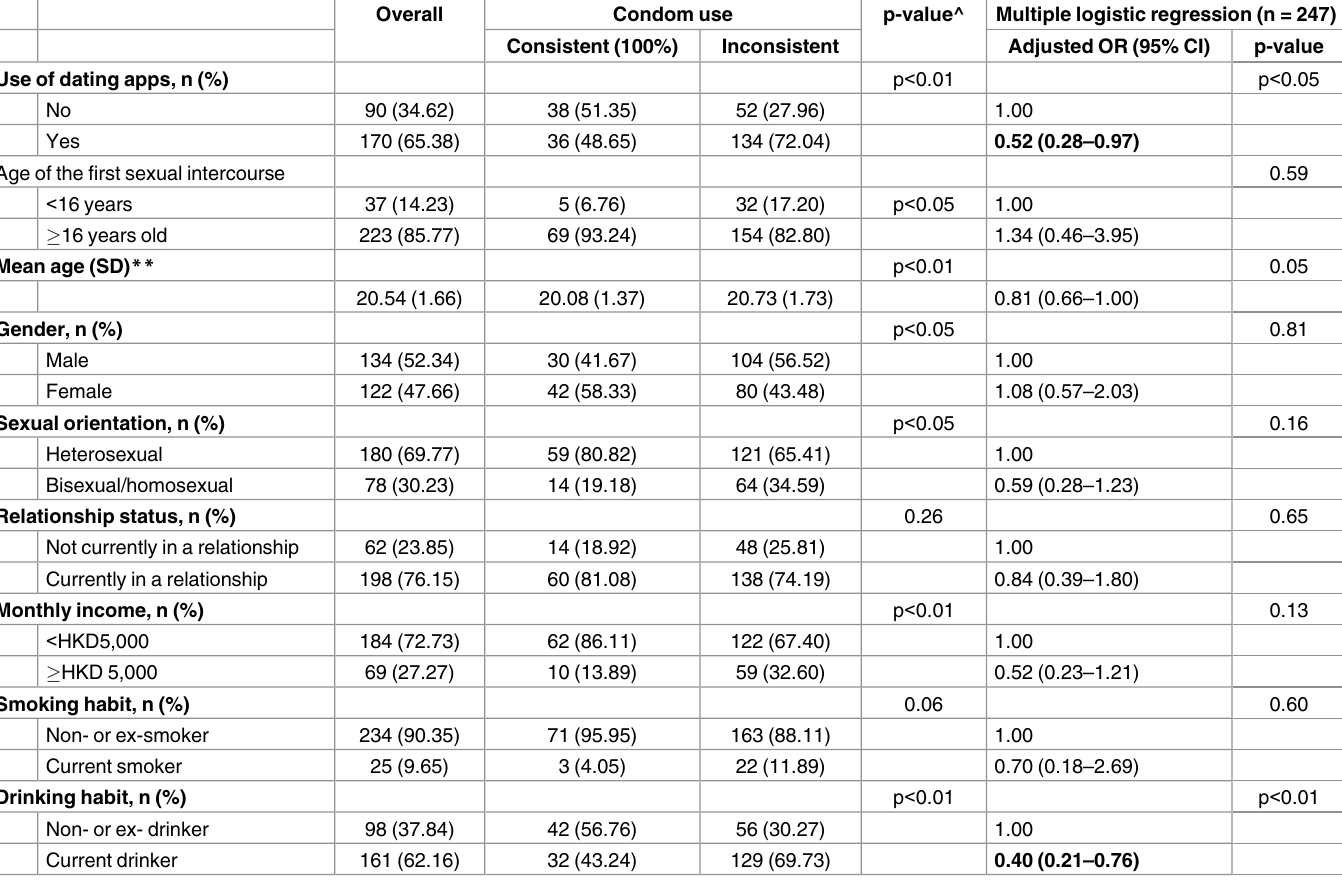
Table 6. Correlates of consistent condom use by multiple logistic